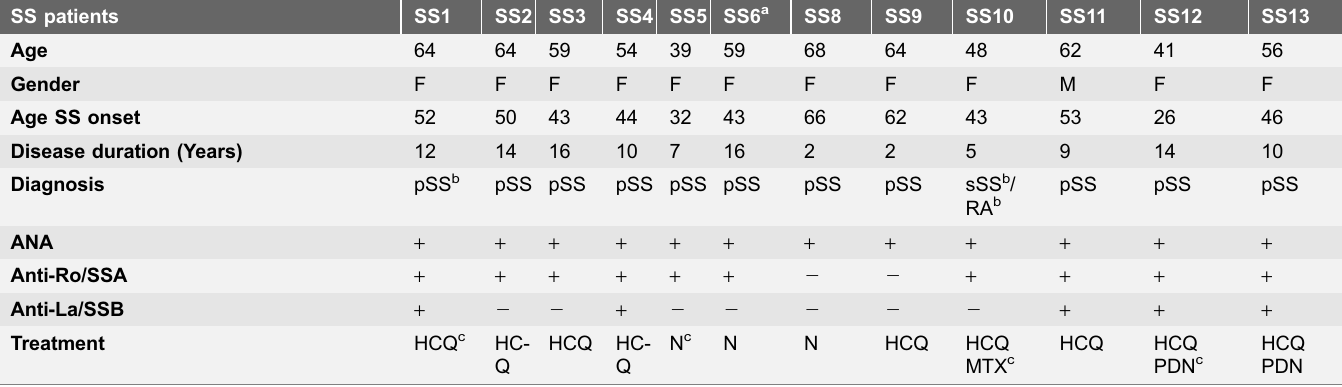
Table 1. SS patients analysed in this